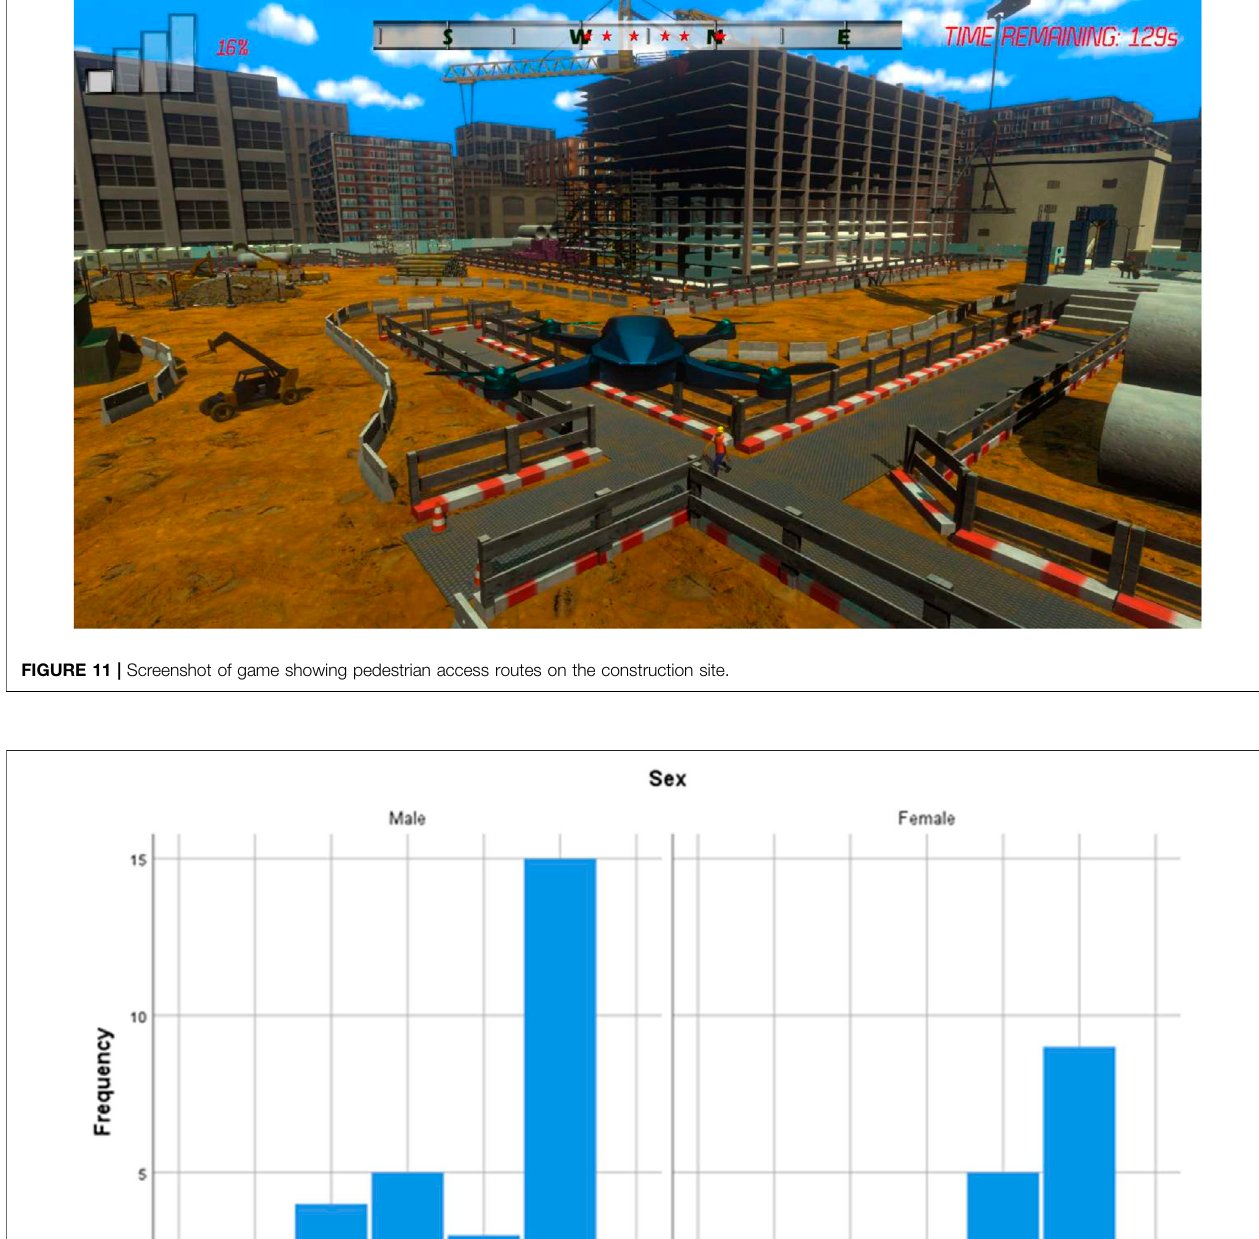
Frontiers in Built Environment |